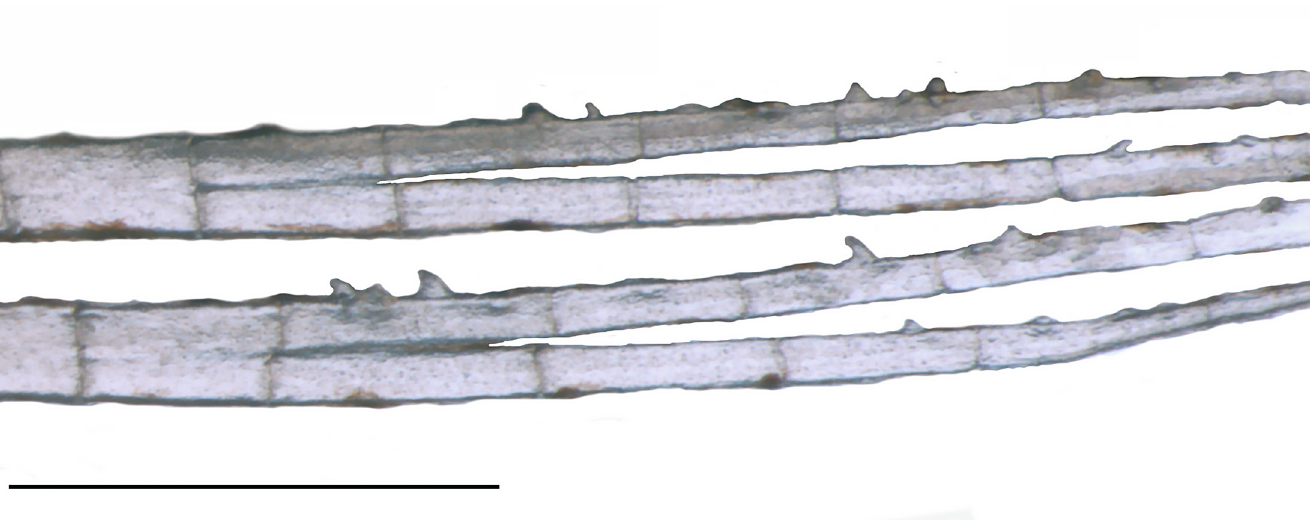
PLOS ONE | https://doi.org/10.1371/journal.pone.0226130 December18,